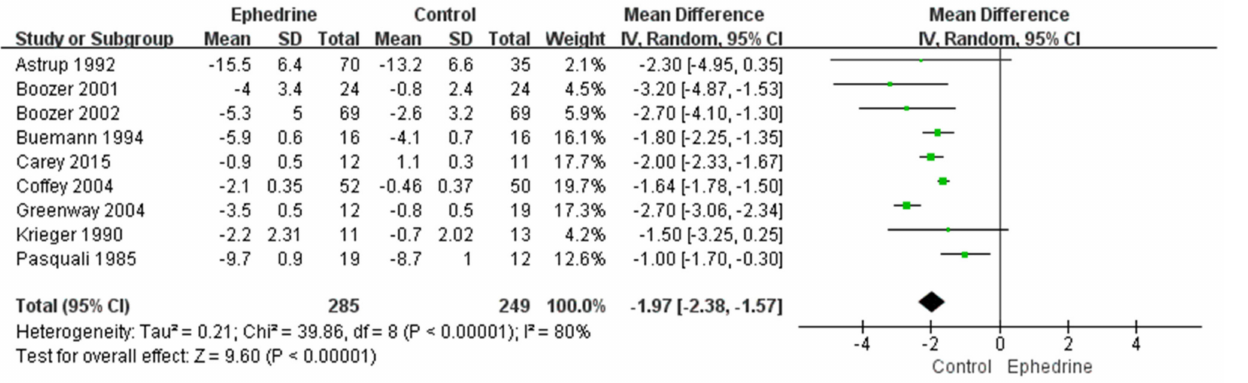
Figure 2. Forest plot to compare weight loss (kg) between ephedrine-containing products and placebo in obese or overweight